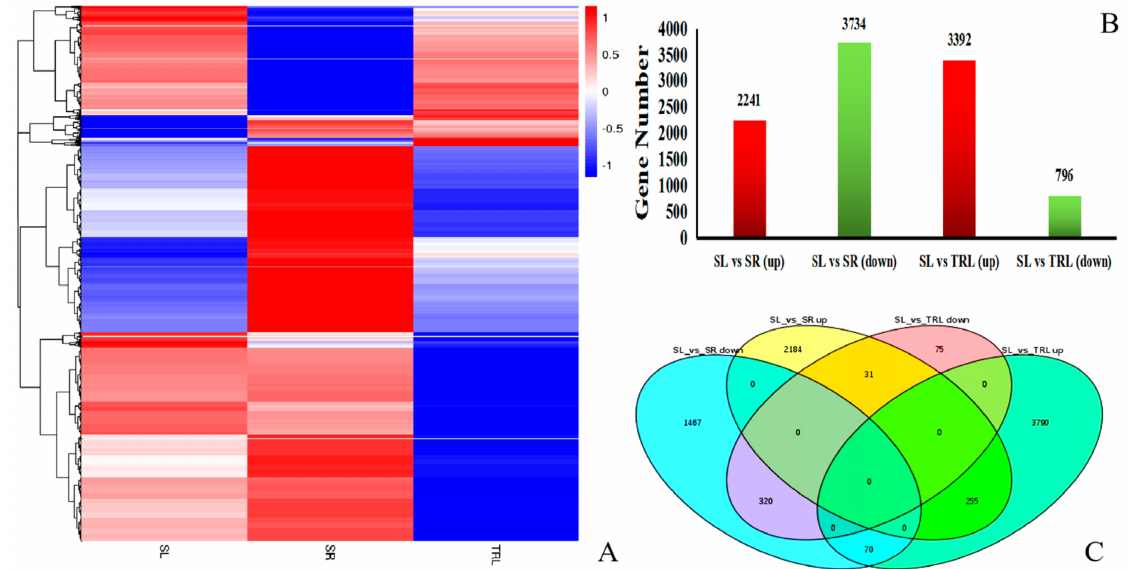
Figure 1. Di ff erentially expressed gene (DEG) hierarchical clustering. ( A ) Heat map showing genes with di ff erential expression (fold ≥ 1, false discovery rate (FDR) ≤ 0.001) among the three replicates of the SR (root), SL (sporophyll), and TRL (sporophyll with glandular trichomes removed). Expression values are log2-transformed and median-centered by gene. Scaled log2 expression values are shown, with red and blue indicating high and low expression, respectively. ( B , C ) Di ff erences in gene expression in three